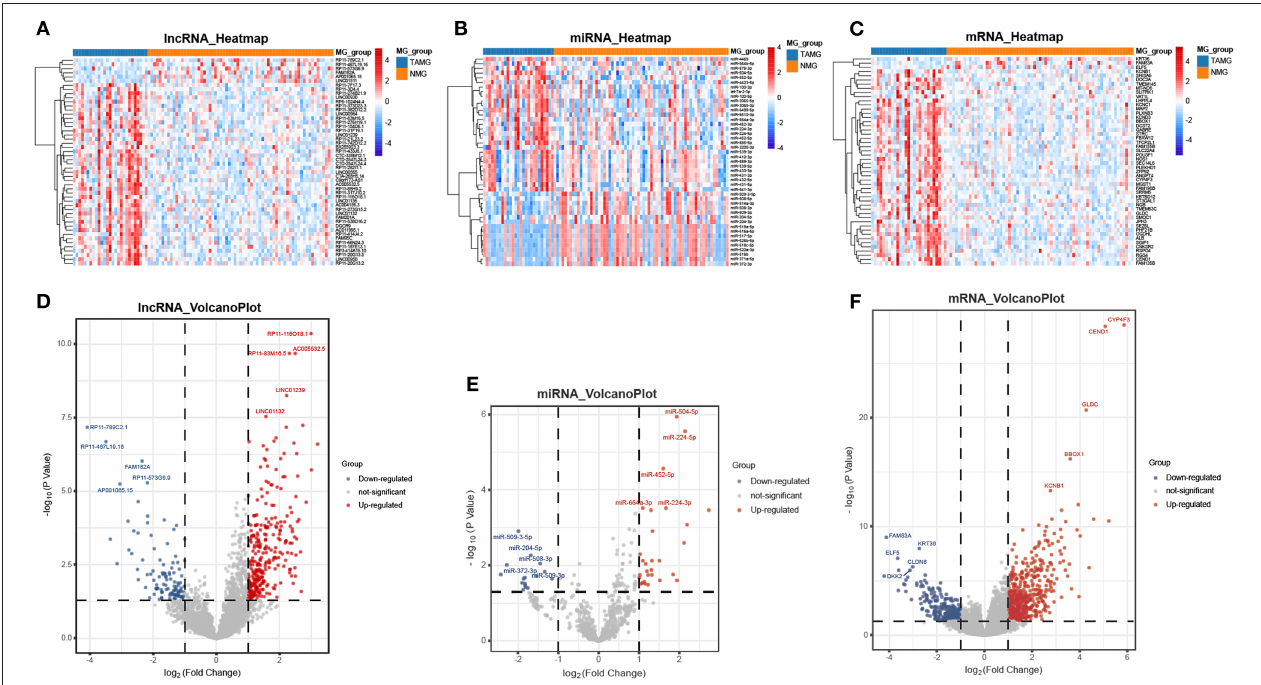
FIGURE 1 | Differentially expressed genes between TAMG and NMG. (A) Heatmap of the 50 most differentially expressed lncRNAs; (B) Heatmap of the 45 differentially expressed miRNAs; (C) Heatmap of the 50 most differentially expressed mRNAs; (D–F) Volcano plot of differentially expressed lncRNAs, miRNAs, and mRNAs. The five most upregulated and five most downregulated genes are marked in the volcano plots.